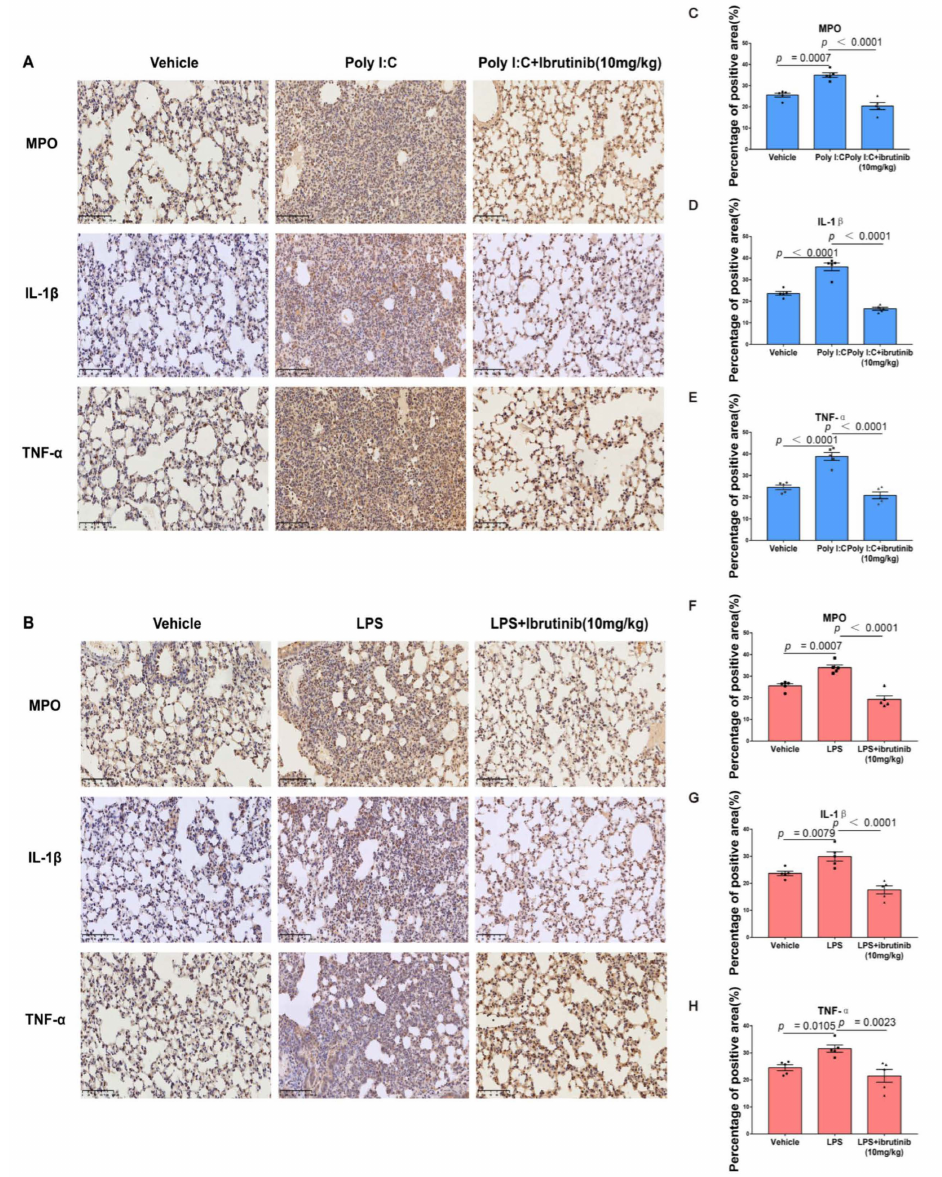
Figure 5. Effects of ibrutinib on the levels of MPO, IL-1 β , and TNF- α in the lungs after poly I:C- and LPS-induced lung injury. ( A ) Representative immunohistochemical images of lung sections at 48 h after intratracheal treatment with poly I:C. ( B ) Representative immunohistochemical images of lung sections at 24 h after intratracheal treatment with LPS. ( C – H ) Proportions of MPO-, IL-1 β -, and TNF- α -positive cells were semi-quantified using Image J. The magnification was 200 × , the scale bar = 100 µ m, and all images are of the same scale. Values are shown as means ± SEM for n =